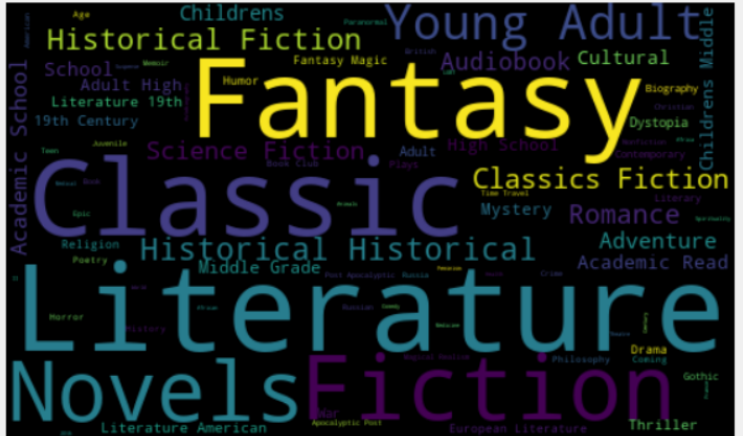
Figure 4. Genres of the collected